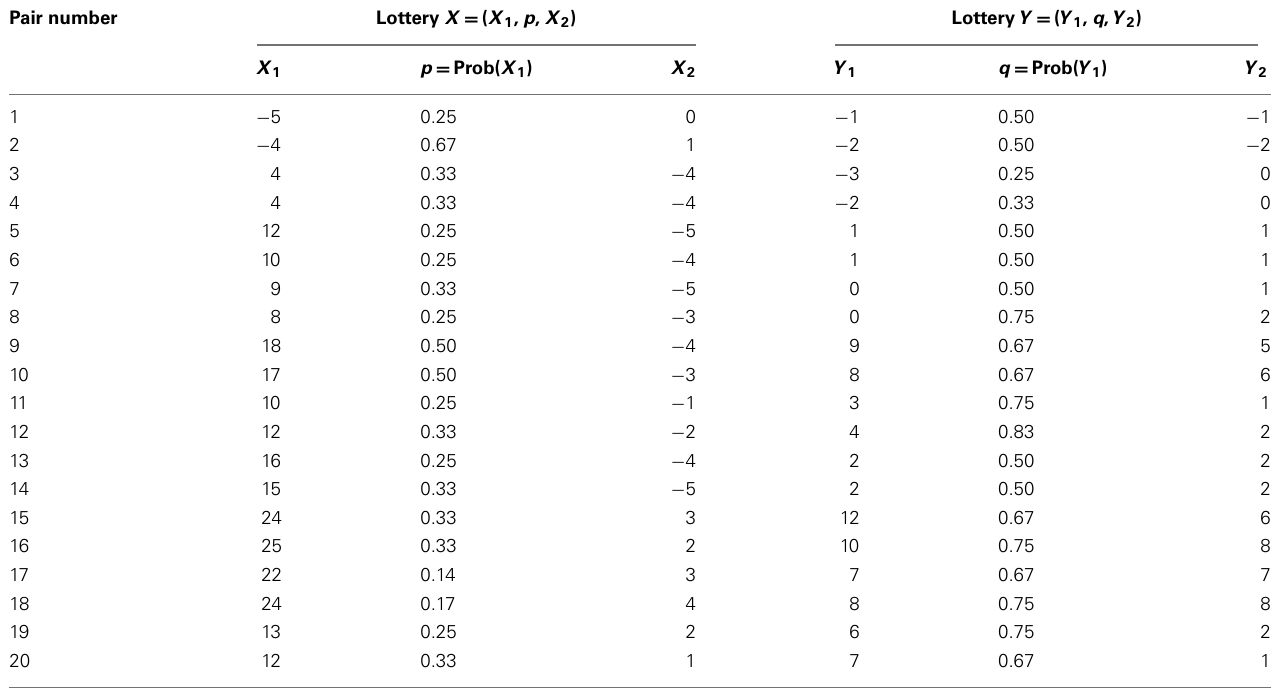
TableA1 | Lotteries used in the experiment.